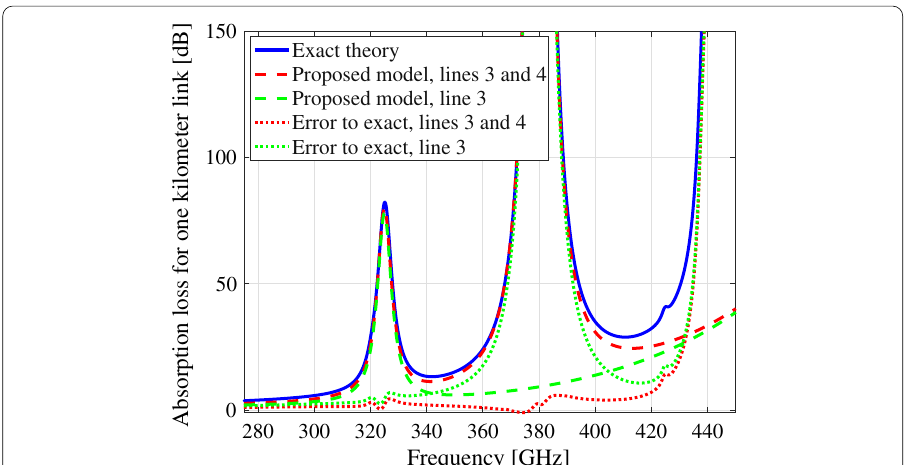
Fig. 7 Performance of the proposed model with reduced terms, high band. Reduced versions of the proposed model giving absorption losses up to about 330 GHz (3rd line only) and 390 GHz (lines 3 and 4 only)